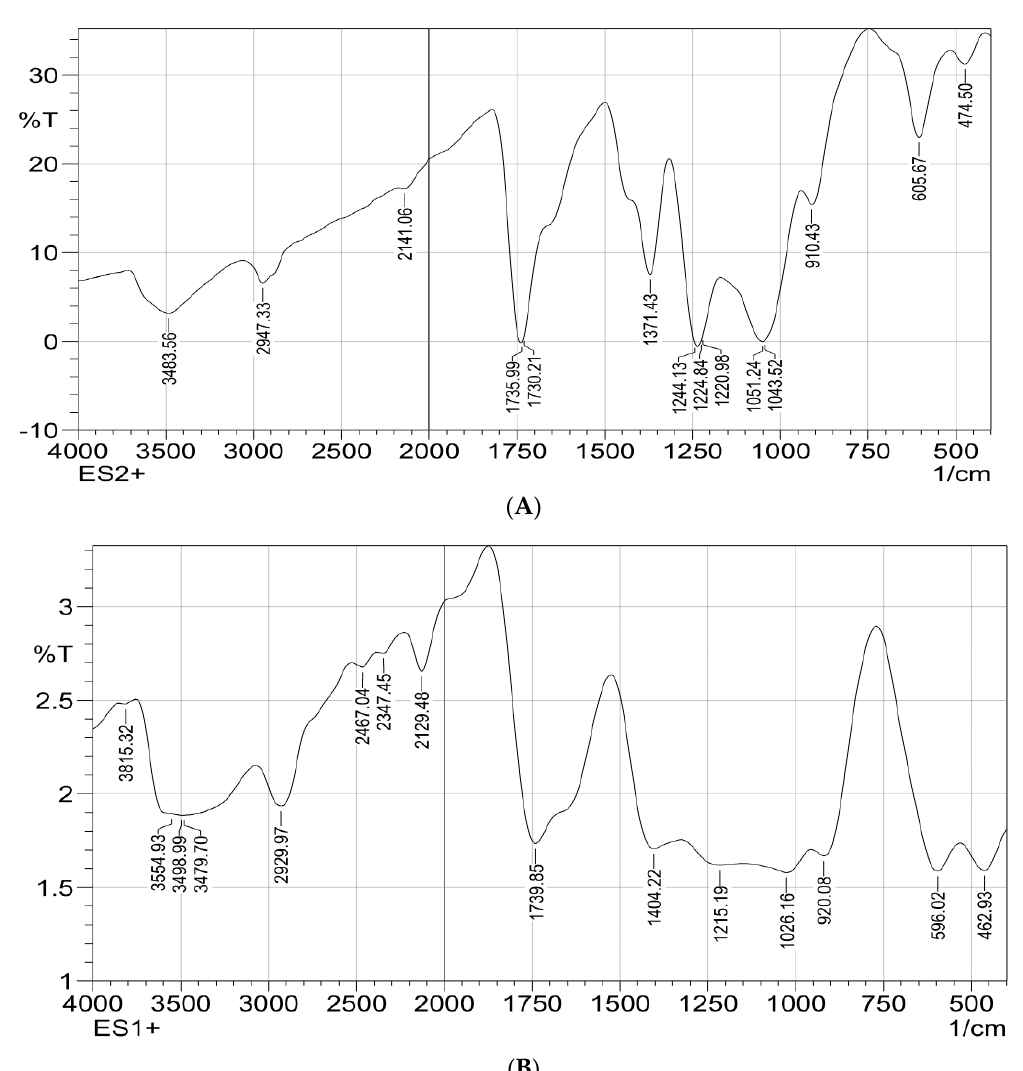
Figure 4. FTIR spectrophotometric analysis for ZnO polymeric composite nanofiber ( A ) before silver immobilization and ( B ) after silver immobilization.